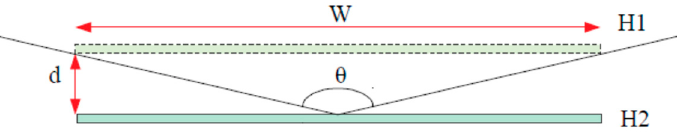
Figure 3. Hologram H2 oblique field of view without visual distortion.